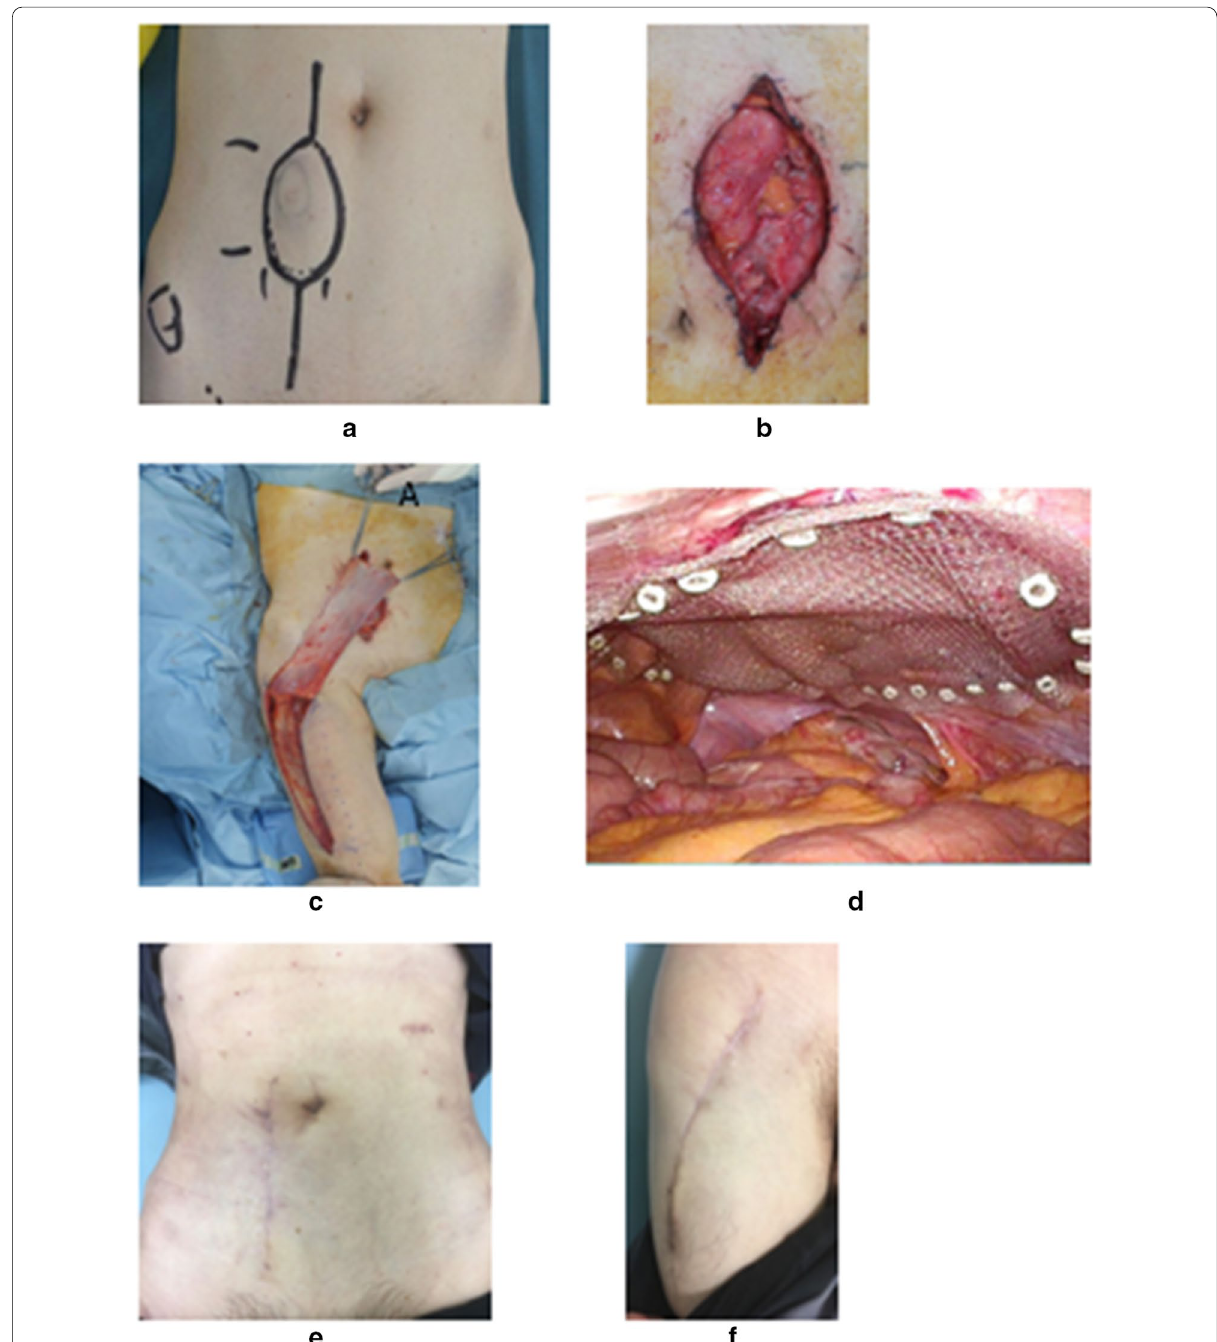
spindled fibroblastic cells arranged in a herringbone pat- tern, with hemorrhagia and necrosis in the side of the tumor. Areas of hypercellularity were interspersed